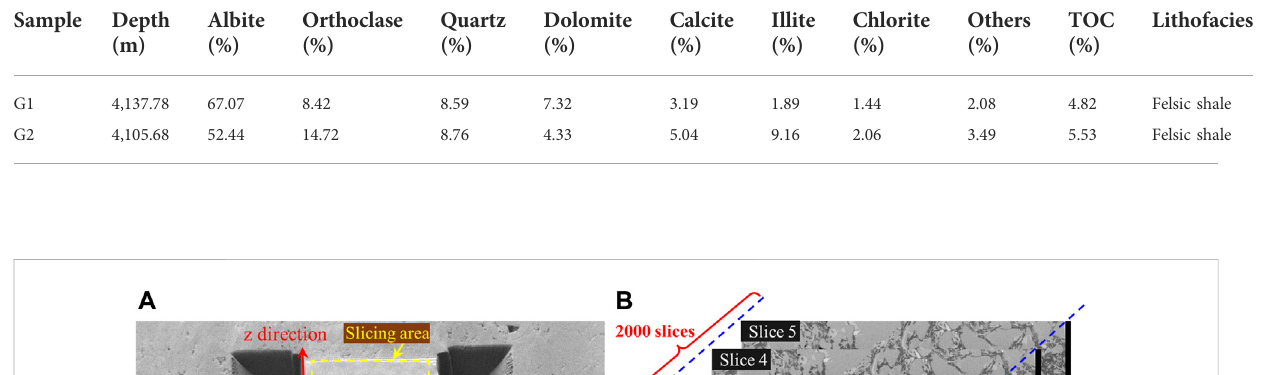
TABLE 1 Summary of mineral compositions and lithofacies of investigated